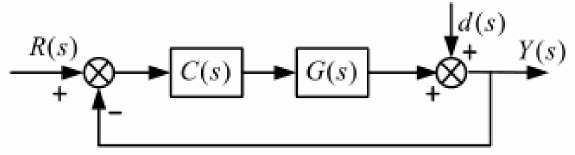
Figure 12. Structural diagram of common feedback control